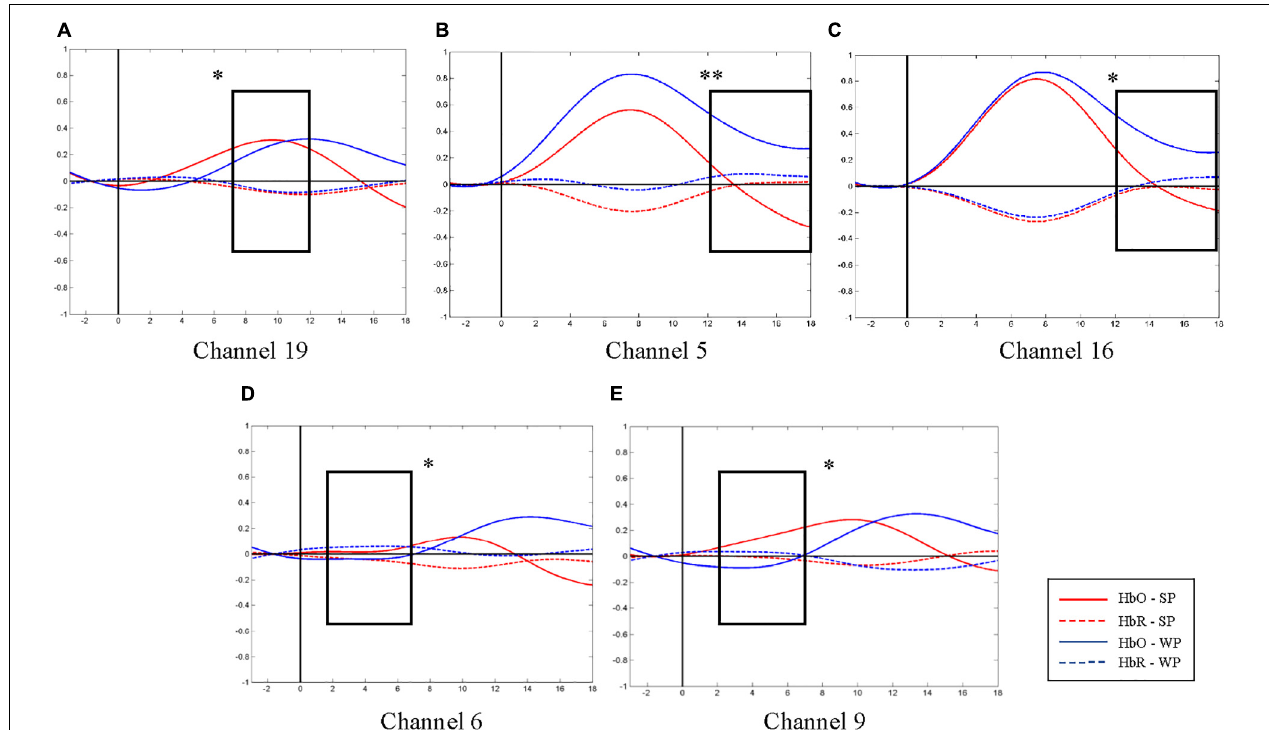
FIGURE 5 | Average oxygen-hemoglobin concentrations (HbO) envelopes of the normal hearing (NH) group in the chosen time windows. (A) Channel 19 (the right middle temporal gyrus) had more significant activation in 7–12 s under strong-prosodic (SP) condition [ F (1,48) = 4.086, p FRD - cor = 0.049]. (B,C) Weak-prosodic (WP) stimuli evoked more significant activation in channels 5 [ F (1,48) = 9.543, p FRD - cor = 0.003] and 16 [ F (1,48) = 4.398, p FRD - cor = 0.041] in 12–18 s. (D,E) Channels 6 [ F (1,48) = 4.358, p FRD - cor = 0.042] and 9 [ F (1,48) = 4.636, p FRD - cor = 0.036] showed significant stronger responses to SP. * p < 0.05 and ** p < 0.01.